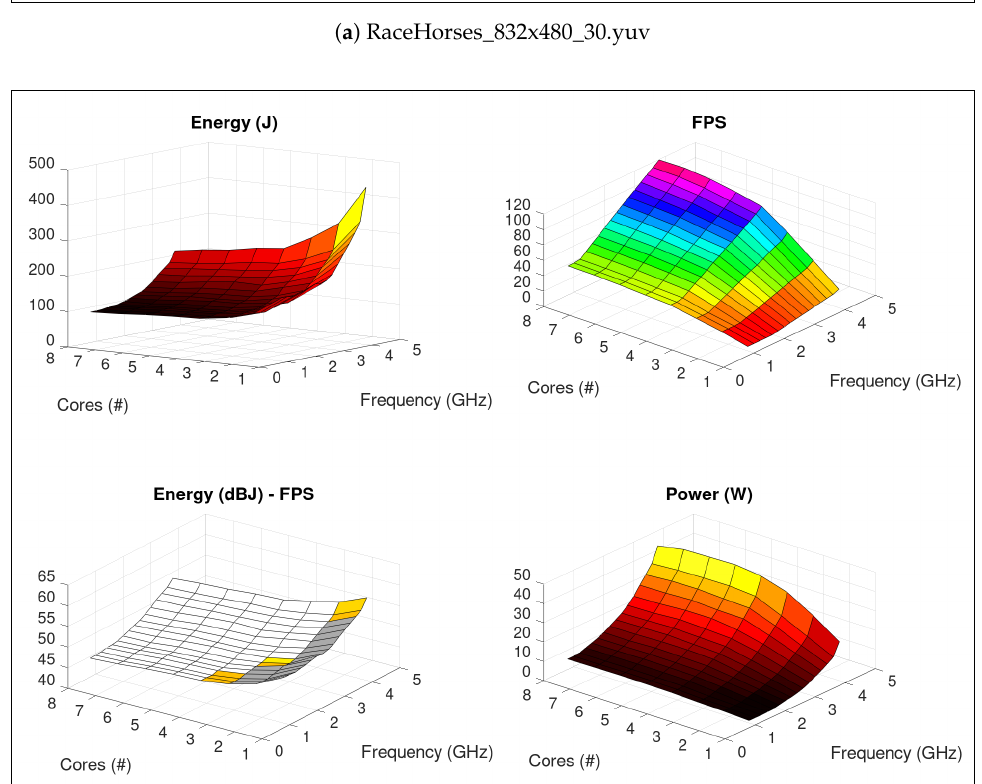
Figure 4. HEVC—profiling on a Intel Core i7-7700 system. On Energy and Power, lighter colors represent higher values. FPS colors are defined in HSV scale, corresponding to application performance levels. On Energy—FPS chart, gray represents settings with application performance below defined threshold; white regions group system configurations that exceed QoS levels; HSV colors reflect out same application performance levels as